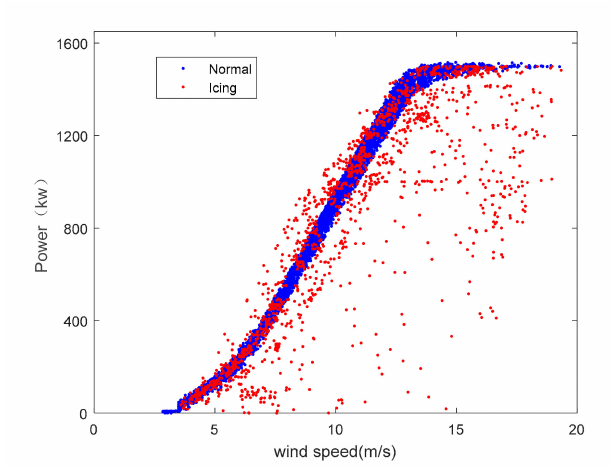
Figure 3. Wind turbine (WT) speed–power scatter plot (red is the freezing point and blue is the normal